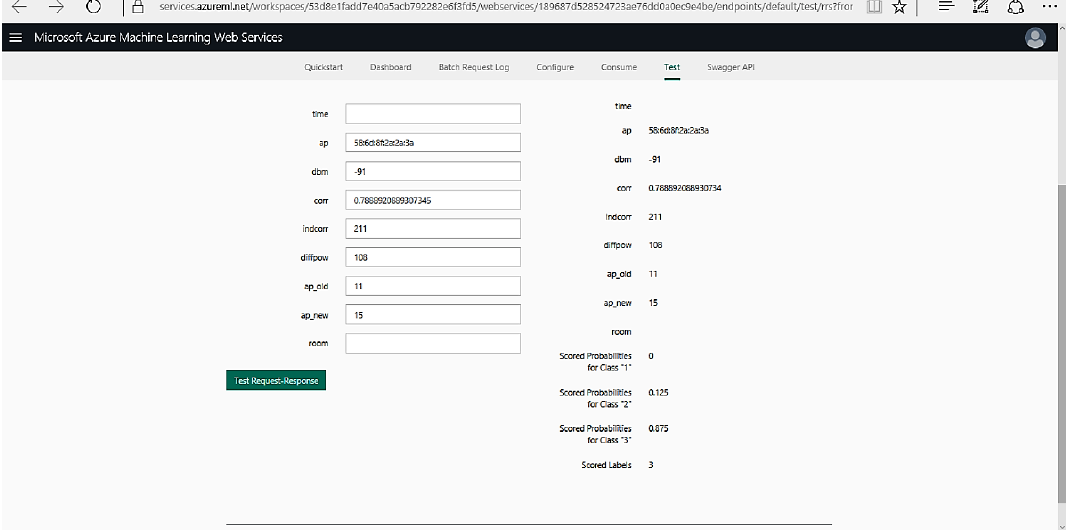
Figure 24. Prediction model implemented as a Web